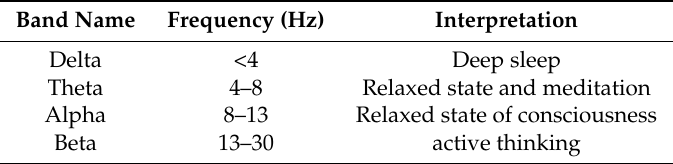
Table 1. Basic brain wave with their frequency.